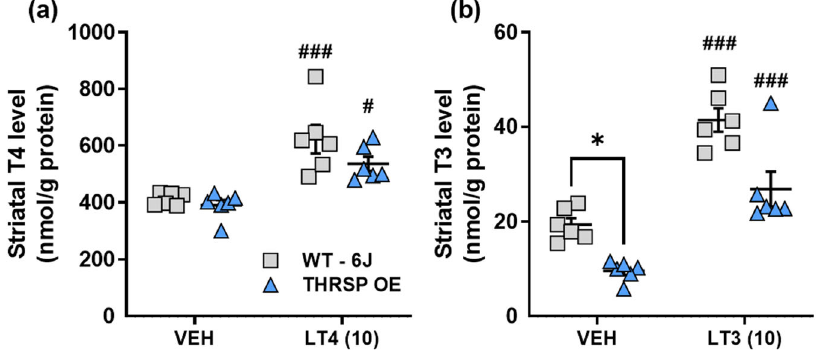
Fig. 9 Effects of TH replacement on the striatal T3 levels in THRSP OE mice. a T4 and b T3 were evaluated following seven days of LT3 and LT4 (10 mg kg − 1 ) treatment. On the last day of treatment, the brains were harvested, and the striatum was subjected to TH level analysis ( n = 6 mice/group; a two-way ANOVA, F (1,20) = 3.36, P = 0.0802; b two-way ANOVA, F (1,20) = 26.7, P < 0.001). TH replacement improved the striatal T3 and T4 levels in THRSP OE mice. Values are presented as the mean ± S.E.M. * P < 0.05 (relative to WT) and # P < 0.05. ### P < 0.001 (relative to VEH treatment), by two- way ANOVA with Bonferroni ’ s multiple comparison